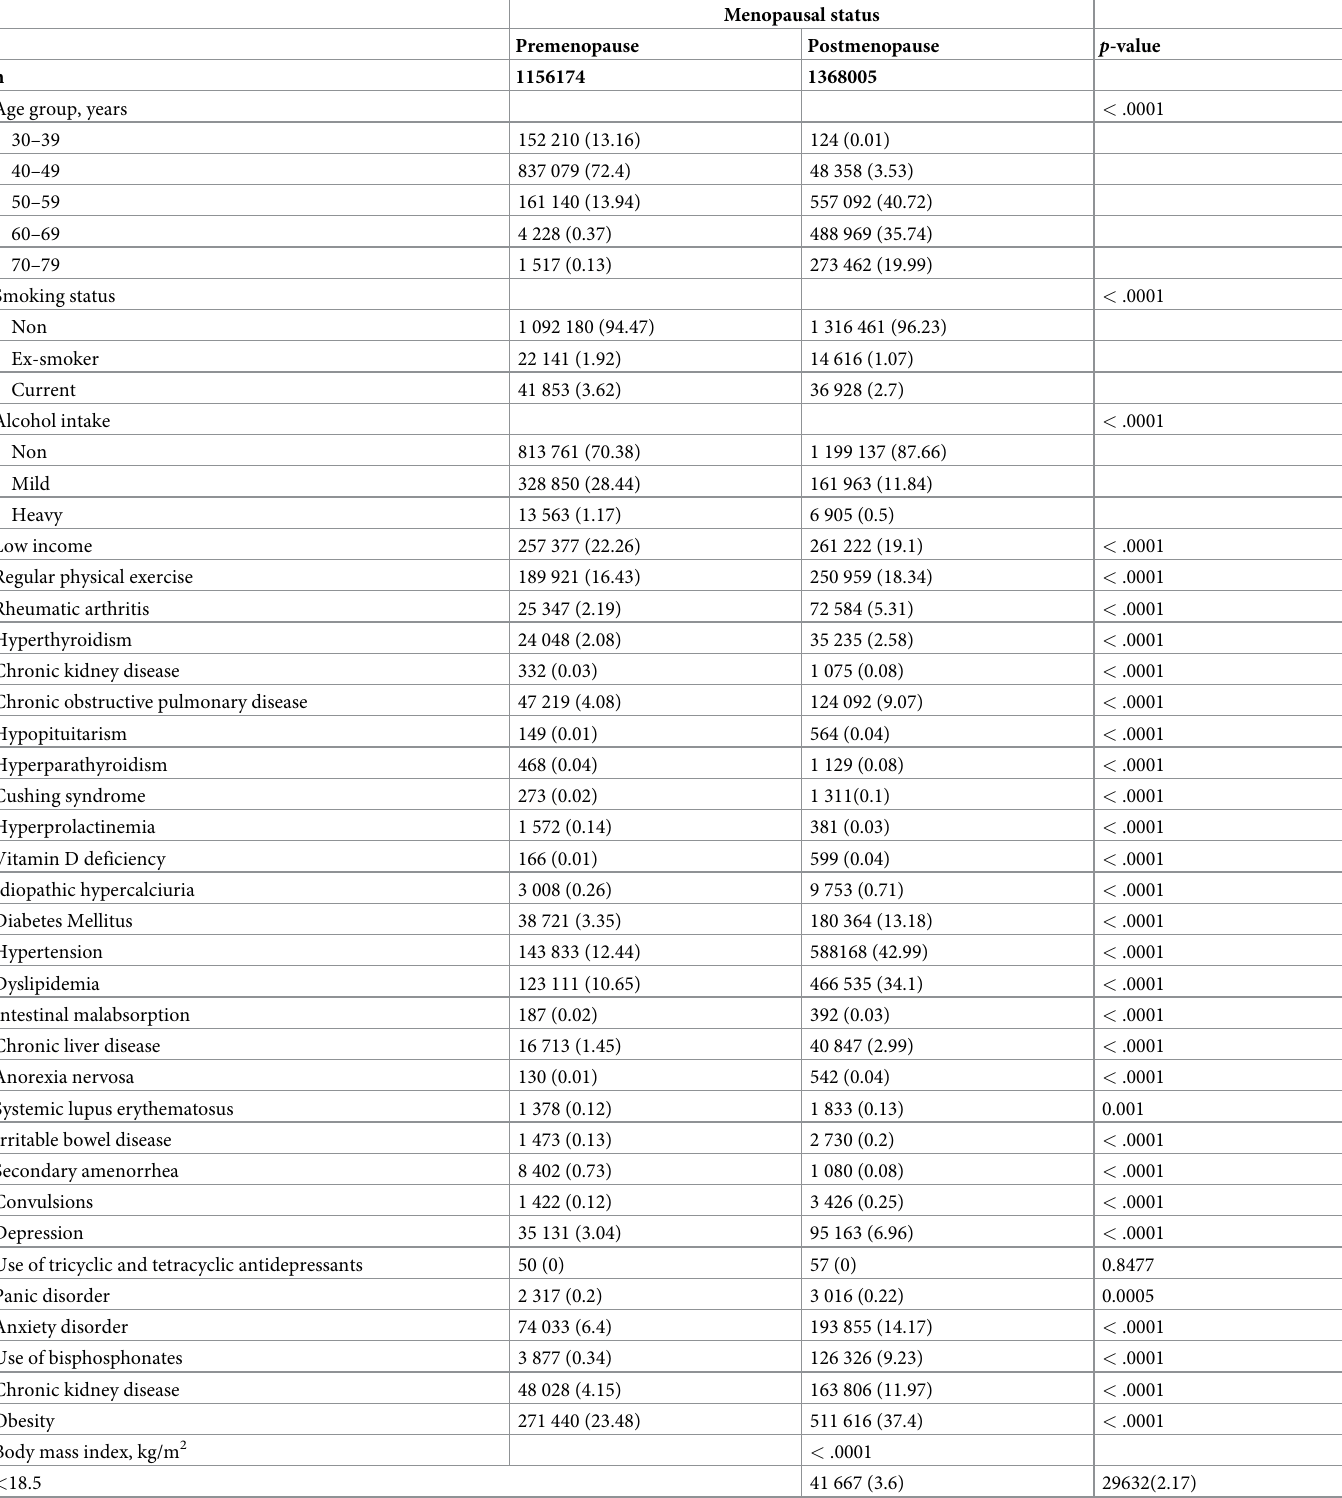
Table 1. Baseline characteristics according to menopausal